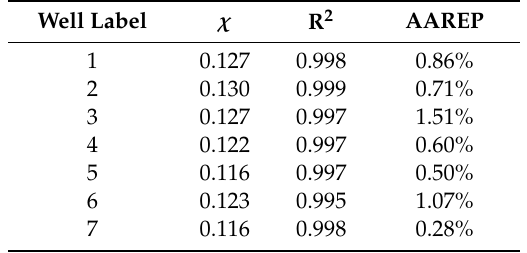
Figure 8. Comparison of fracture conductivity of well 4 between the proposed model and the empirical model. Table 4. Calculated R 2 and AAREP values for TMS wells.